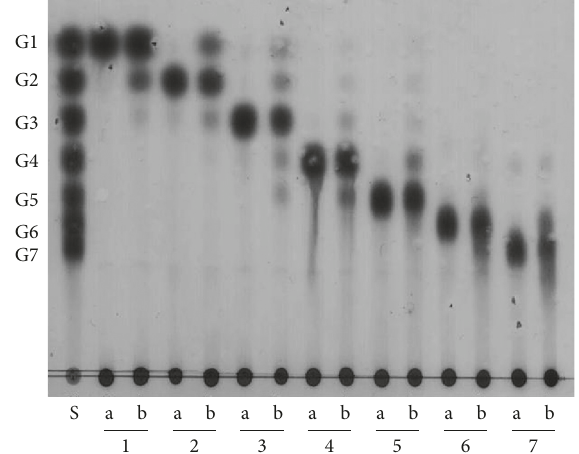
Figure 2: Thin-layer chromatography (TLC) analysis of the transferred products of the Bt α GTase reaction. TLC analysis of the hydrolytic products generated by Bt α GTase. S, standard (G1–G7); lane 1, glucose (G1); lane 2, maltose (G2); lane 3, maltotriose (G3); lane 4, maltotetraose (G4); lane 5, maltopentaose (G5); lane 6, maltohexaose (G6); and lane 7, maltoheptaose (G7). a, before the reaction; b, after the reaction. Hydrolysis was performed at 60 ° C at pH 3.0 for 12